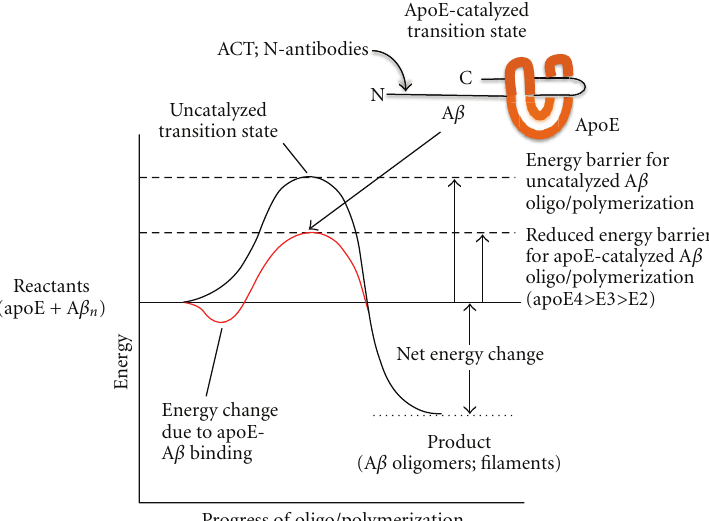
Figure 2: Conceptual energy diagram of ApoE-catalyzed A β oligo/polymerization. Although A β can polymerize spontaneously, the reaction is greatly promoted by apoE in vitro and in vivo . This catalysis can be understood in terms of the energy diagram shown. The first energy change, a reduction, occurs as apoE binds to amino acids 12–28 of A β , with di ff erent apoE isoforms binding with di ff erent a ffi nities. Then apoE apparently alters the structure of its bound A β to a higher-energy β -sheet conformation (the transition state), which allows additional A β molecules to add and form a larger oligomer or fibril. These products have lower energy than either the transition state or the initial reactants (apoE and A β ), thus driving the reaction to completion. Because the energy of the apoE-A β transition state is lower than either the transition state of monomeric A β in a β -sheet conformation, the oligo/polymerization reaction is e ff ectively catalyzed by apoE. ApoE4 evidently forms the lowest energy transition state and thus strongly catalyzes the reaction, apoE3 catalyzes the reaction less well, and apoE2 likely forms such a high energy transition state that it e ff ectively inhibits the spontaneous A β polymerization reaction. Antichymotrypsin (ACT), which binds to A β amino acids 1–12, also catalyzes A β polymerization, while A β antibodies can either promote A β fibrillization themselves or interfere with ACT or apoE-catalyzed polymerization. Molecules, including antibodies, that prevent apoE or ACT binding to A β are being developed as AD therapies that leave the normal physiological functions of A β and apoE or ACT intact, while blocking their pathological